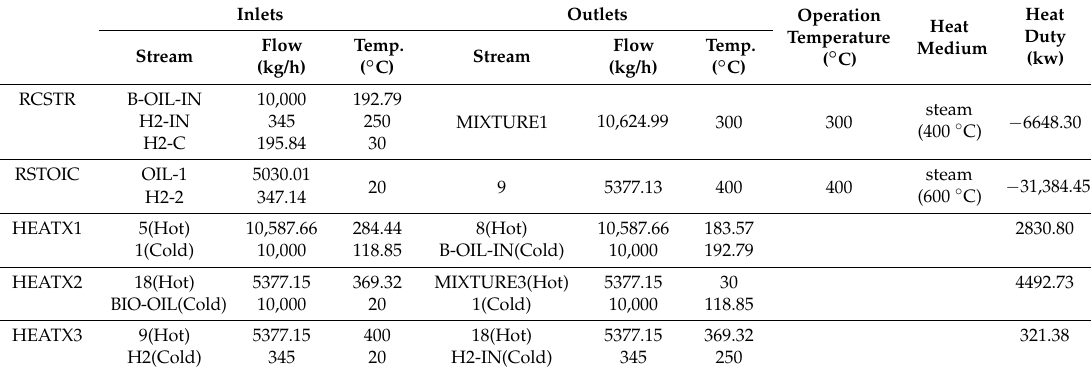
Table A6. Energy analysis of the overall process at 300 ◦ C and 10 MPa and deep hydrogenation at 400 ◦ C and 15